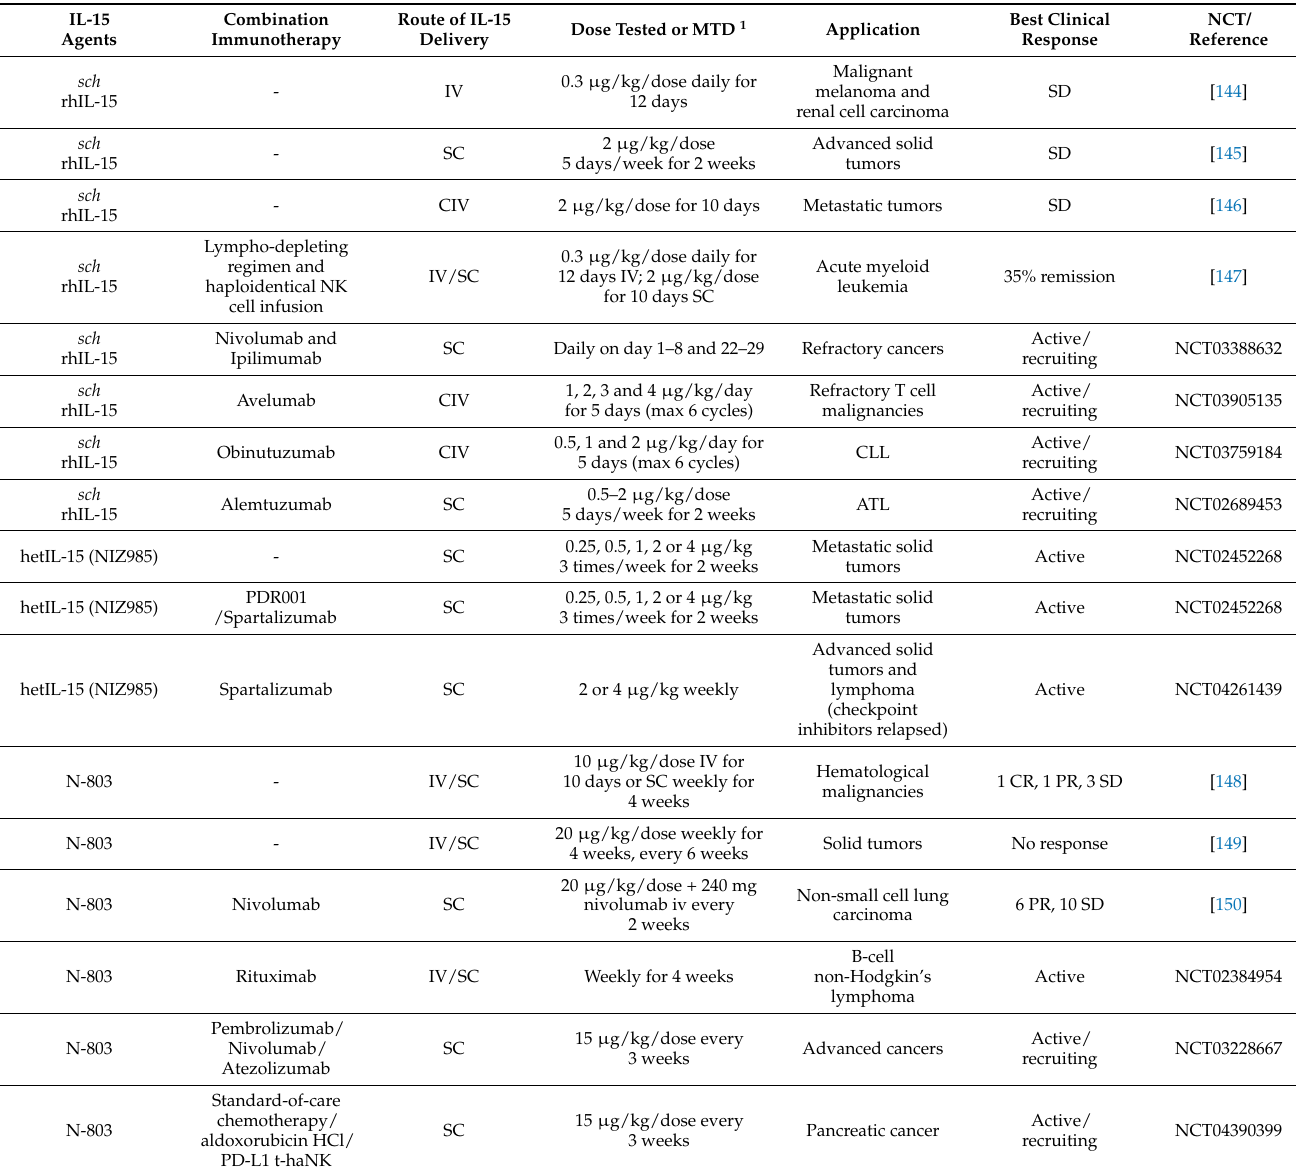
Table 1. Clinical trials with